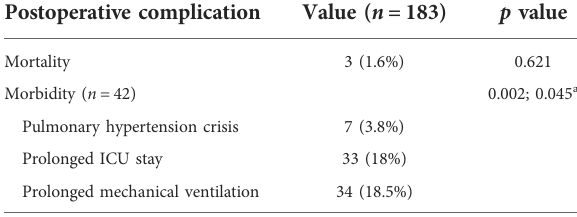
TABLE 4 Postoperative in-hospital mortality and